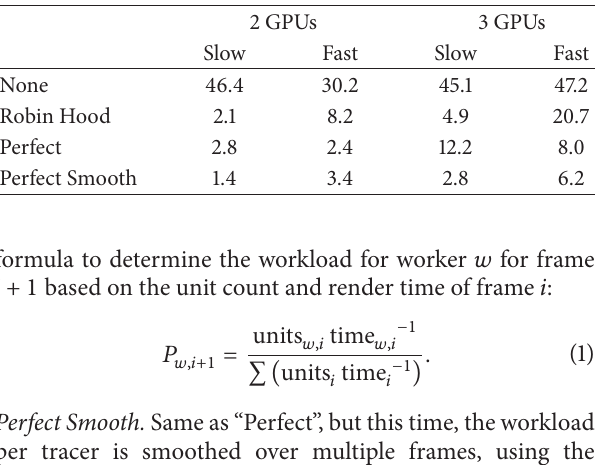
Table 1: Average percentage of summed rendering time for all GPUs spent idling due to early completion, for the four balancing schemes, over 128frames, foraslowand afaster moving camera. Measuredfor the Aztec scene.